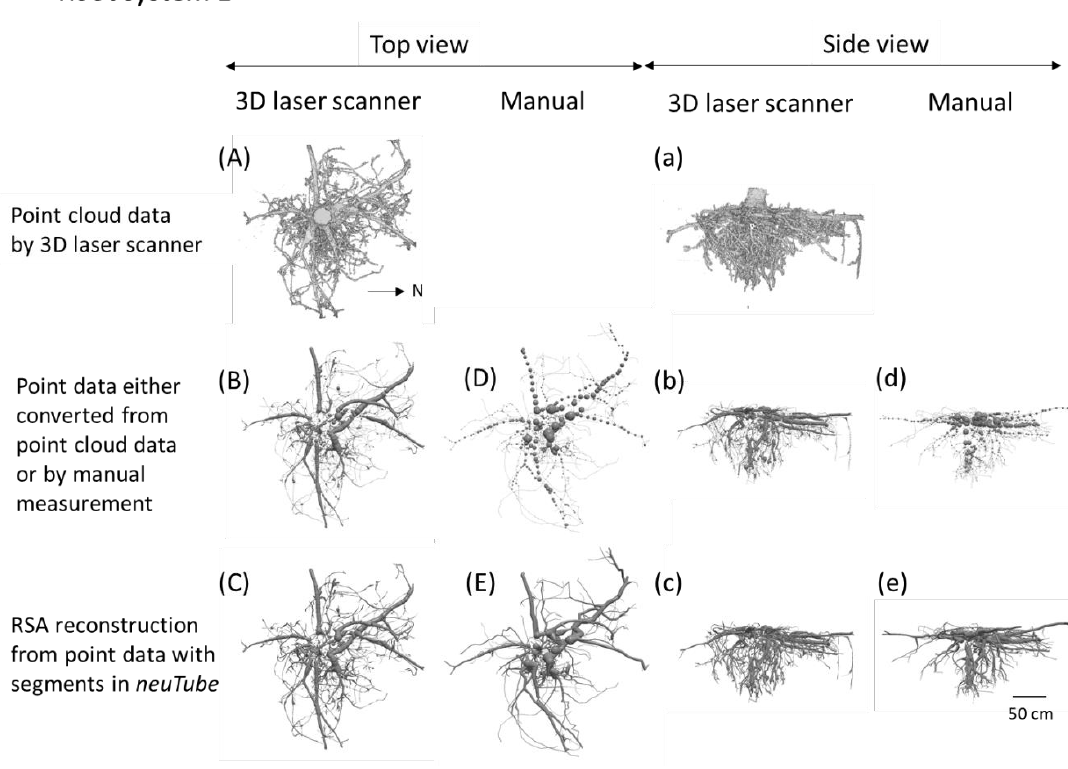
Figure 3. ( A – E ) Top and ( a – e ) side views of Root system 1 drawn from ( A , a ) point cloud data collected by 3D laser scanner; root point data; ( B , b ) converted from point cloud data; ( D , d ) gathered by hand; and ( C , E , c , e ) RSA reconstructed by neuTube software.